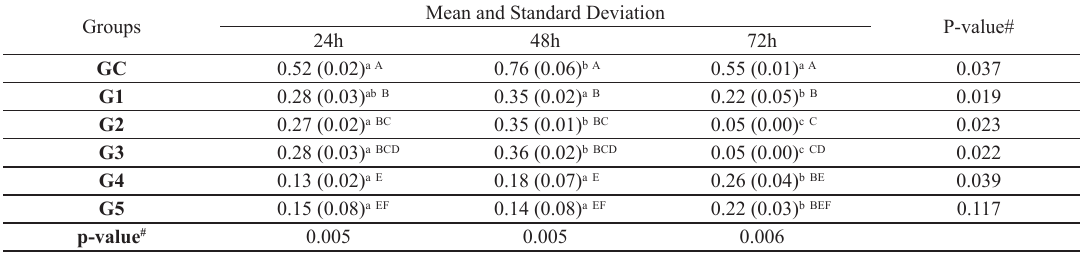
Mean and Standard Deviation